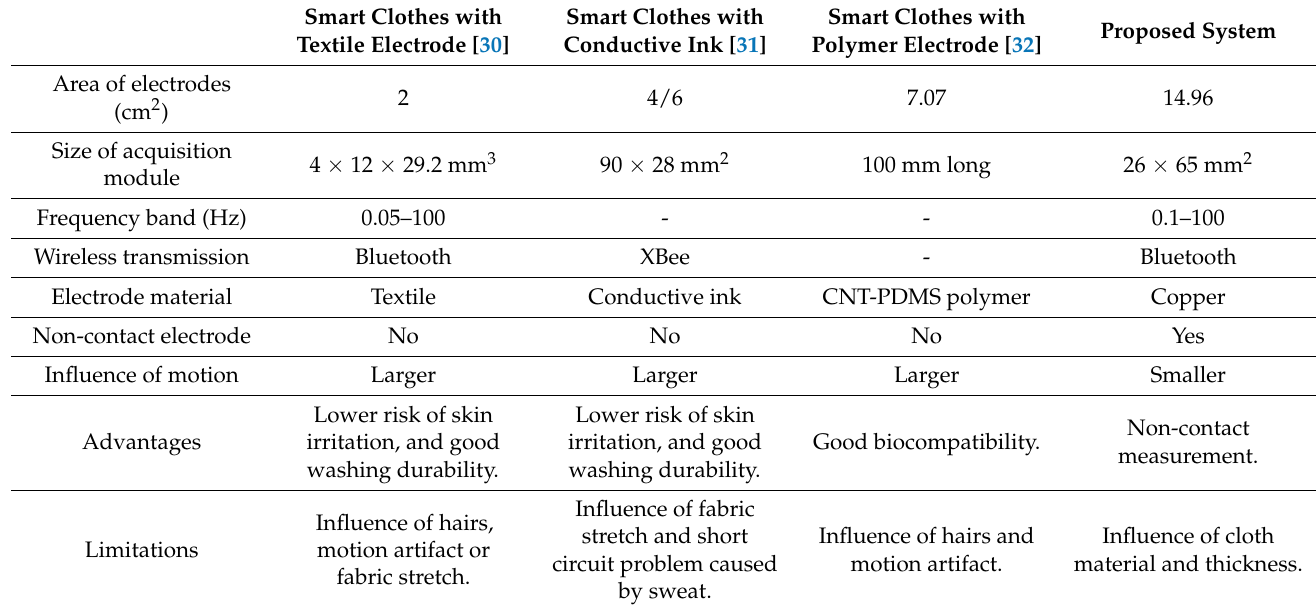
Table 2. Specification comparison between other smart clothes and the proposed smart clothes. Smart Clothes with Smart Clothes with Smart Clothes Textile Electrode [30] Conductive Ink [31]